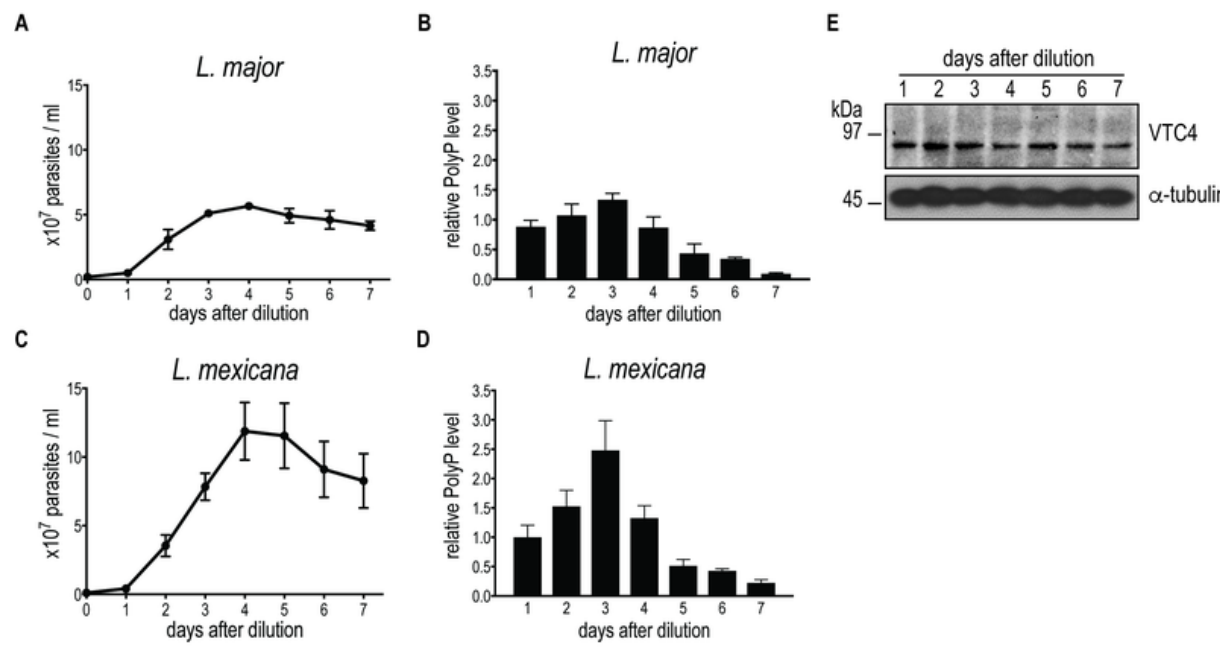
FIGURE 3: PolyP and VTC4 fluctuation during promastigote growth of L. major and L. mexicana. L. major (A) and L. mexicana (C) promastigote cell concentrations were counted in independent cultures. (B, D) PolyP was extracted from cell lines, digested with polyphosphatase and P i were quantified colorimetrically using malachite green. P i concentrations represented polyP content of 3 x 10 7 cells for L. major (B) and 8 x 10 6 cells for L. mexicana (D) . Results of a pool of minimum 3 independent experiments were expressed as mean ± SD. (E) Western blot analysis of